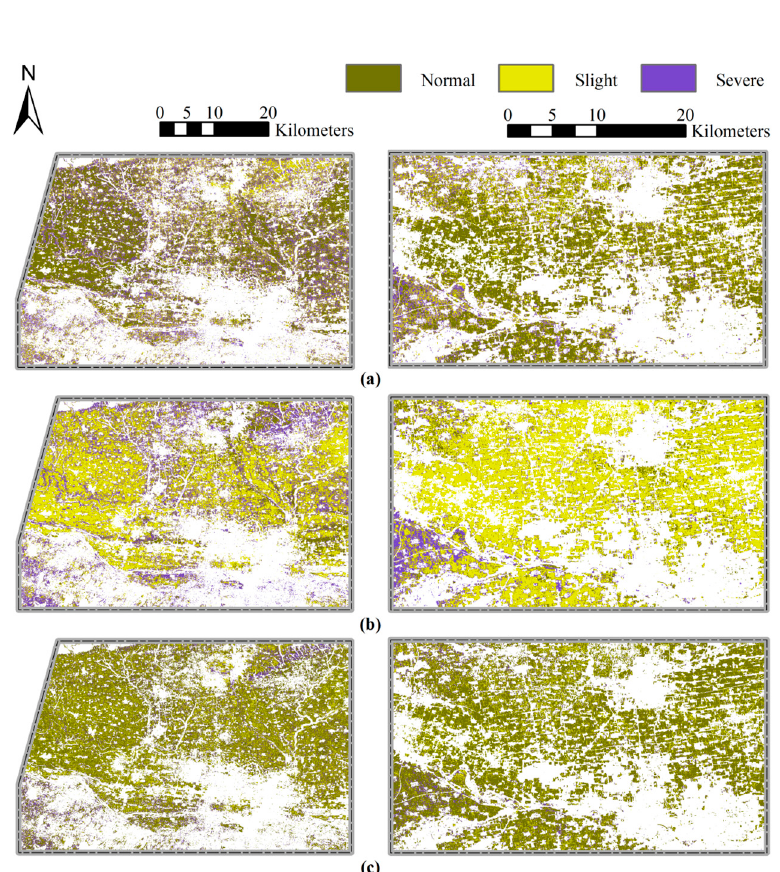
Figure 5. Maps of powdery mildew infection in winter wheat produced by the ( a ) CART, ( b ) BPNN, and ( c ) KNN models using traditional single-date VIs.